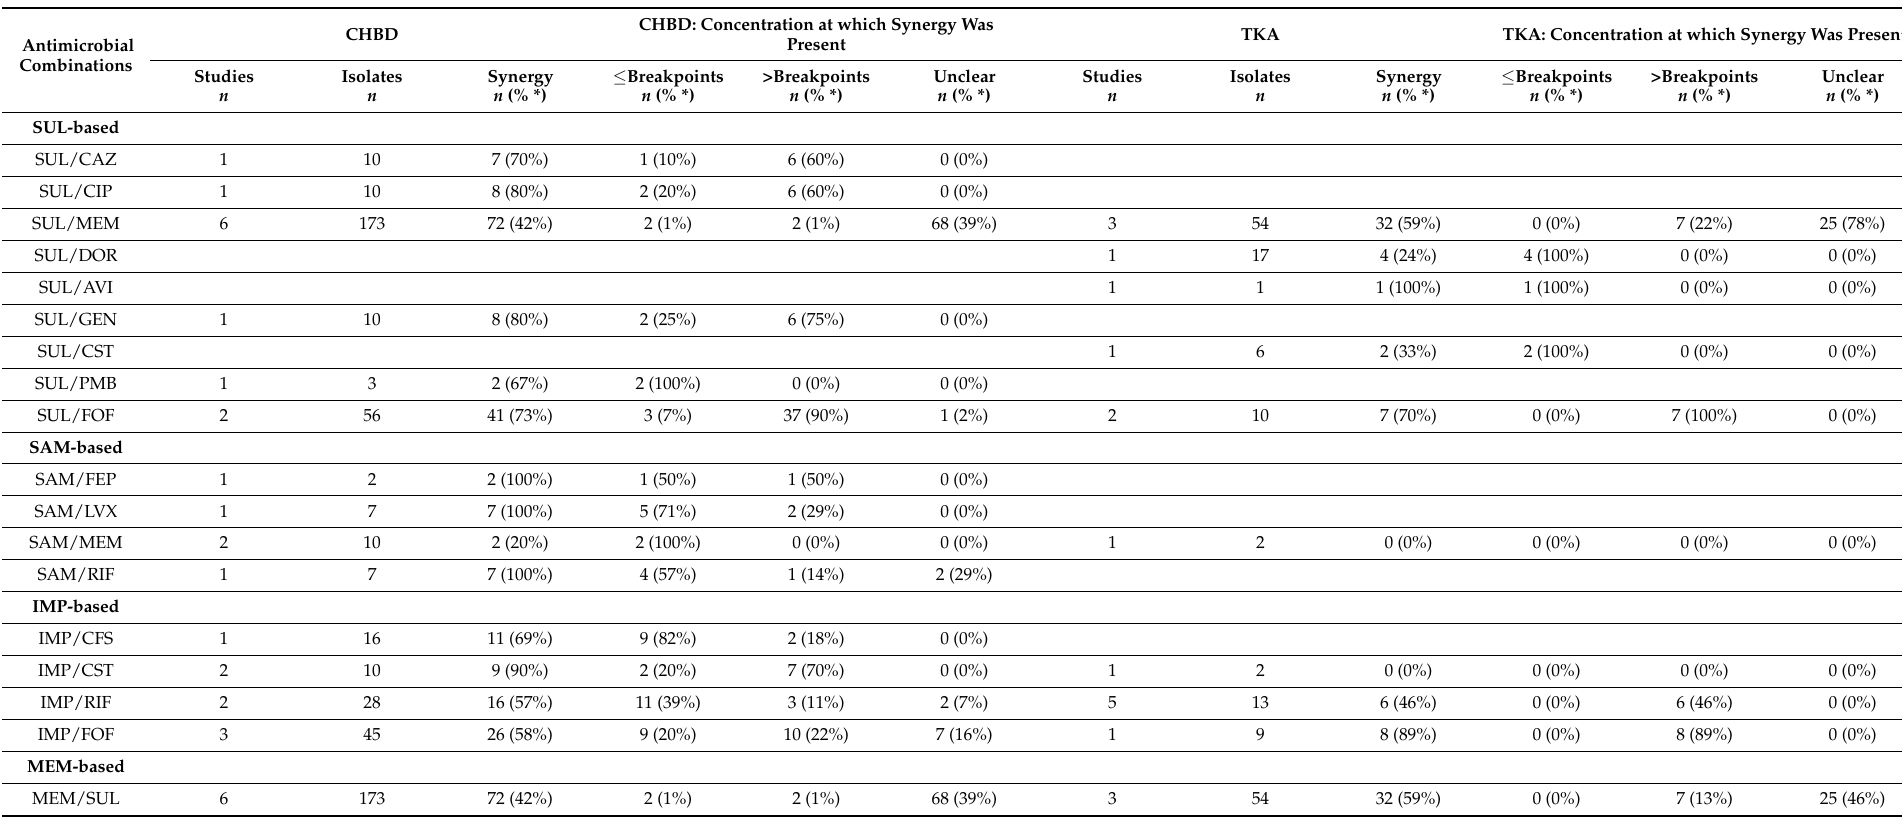
Table A3. Antimicrobial combinations shown to be synergistic in checkerboard (CHBD) and/or time-kill assay (TKA) at concentrations ≤ established breakpoints of resistance. CHBD CHBD: Concentration at which Synergy Was Present TKA TKA: Concentration at which Synergy Was Antimicrobial Combinations